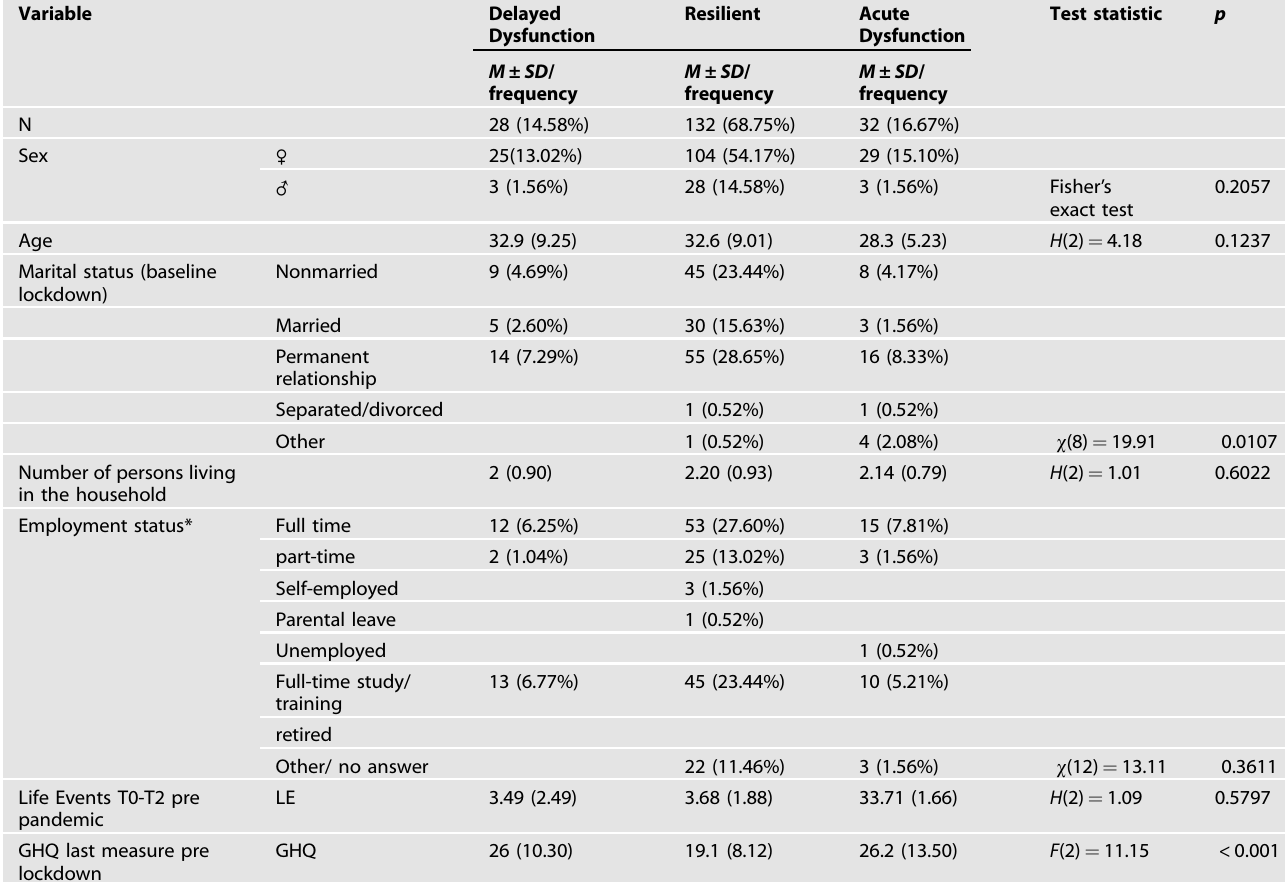
Table 1. Demographics of individuals with hair cortisol data N =